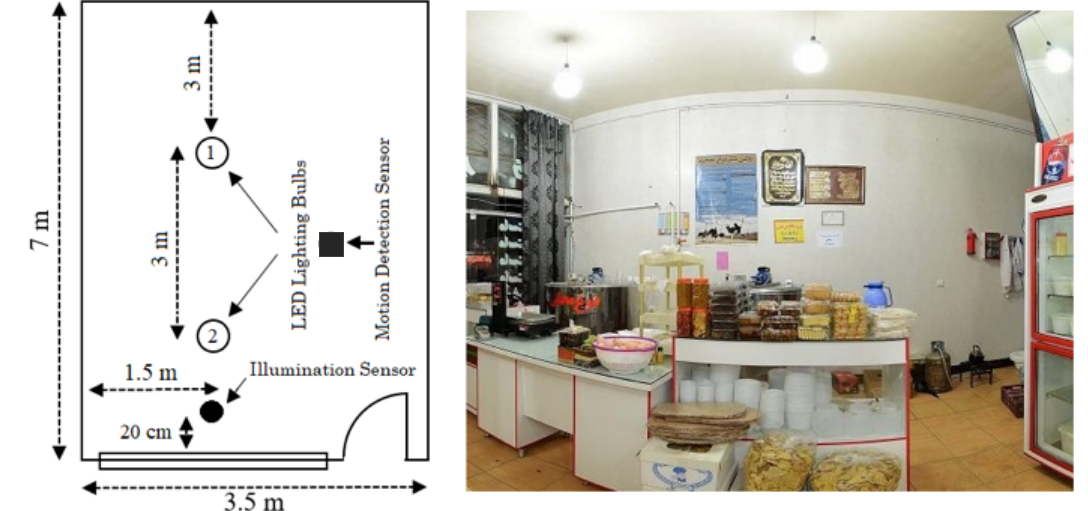
Figure 7. The plan and picture of the dairy